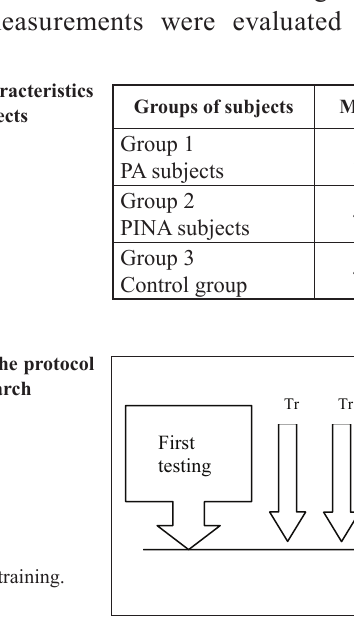
Figure 1. The protocol of the research